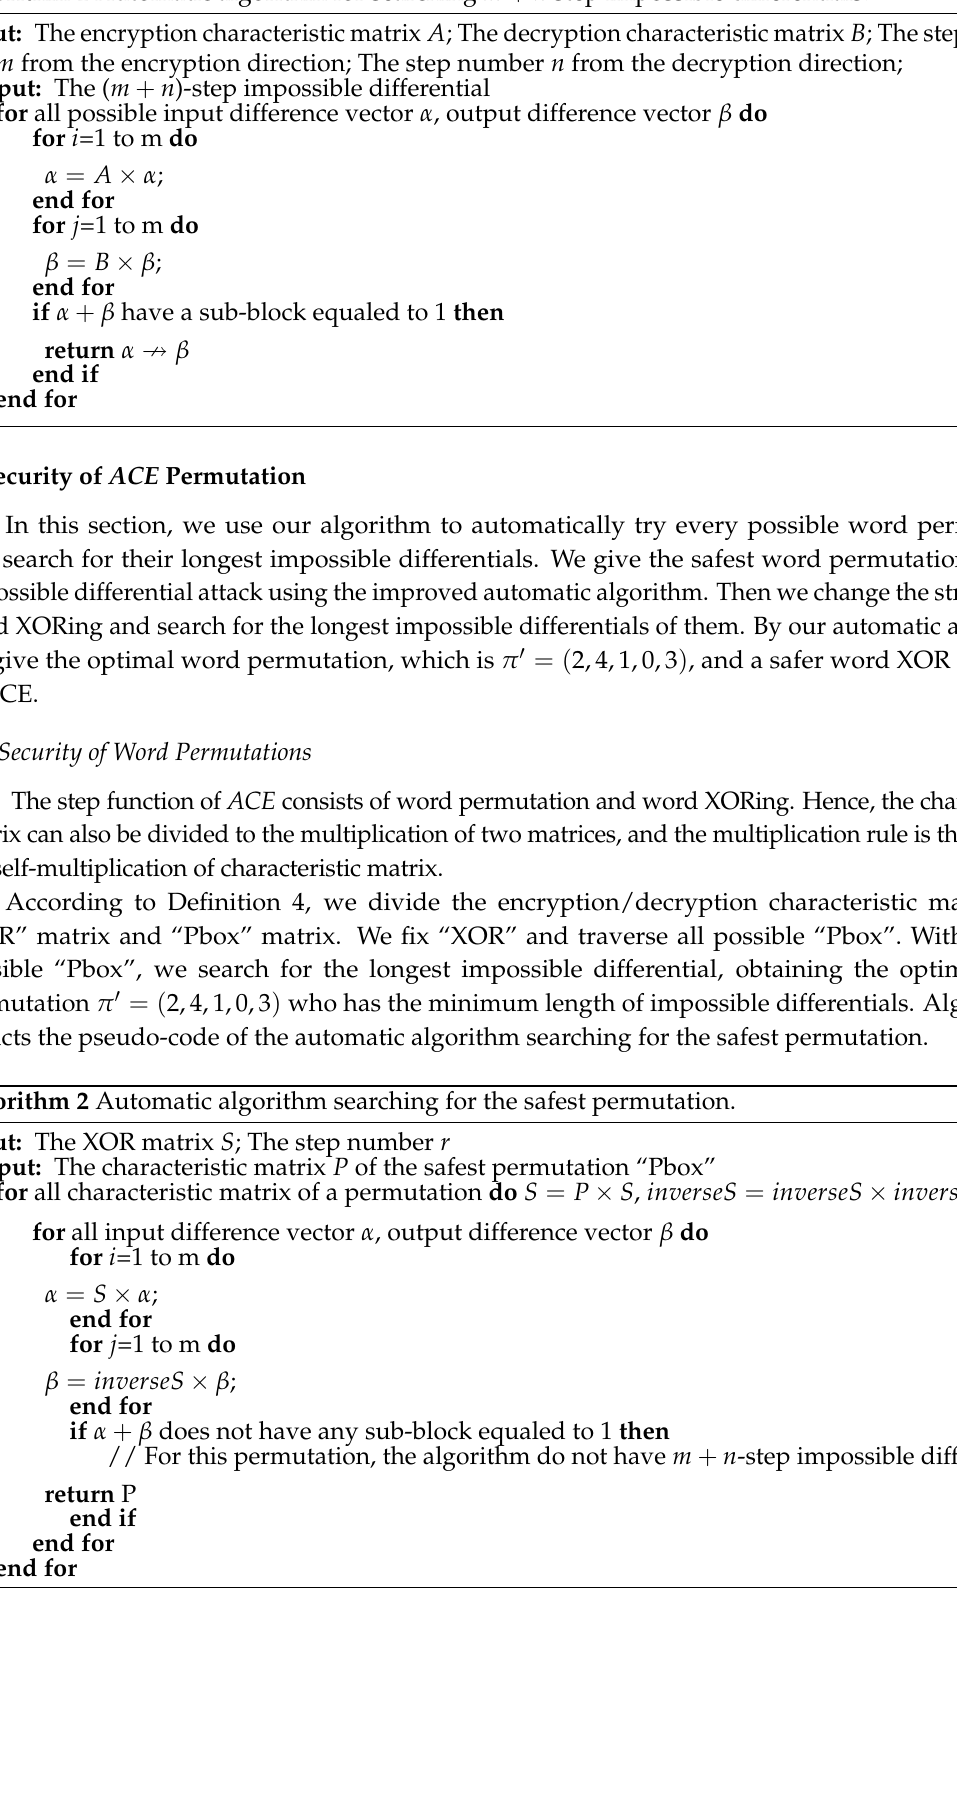
Algorithm 1 Automatic algorithm for searching m + n step impossible differentials.